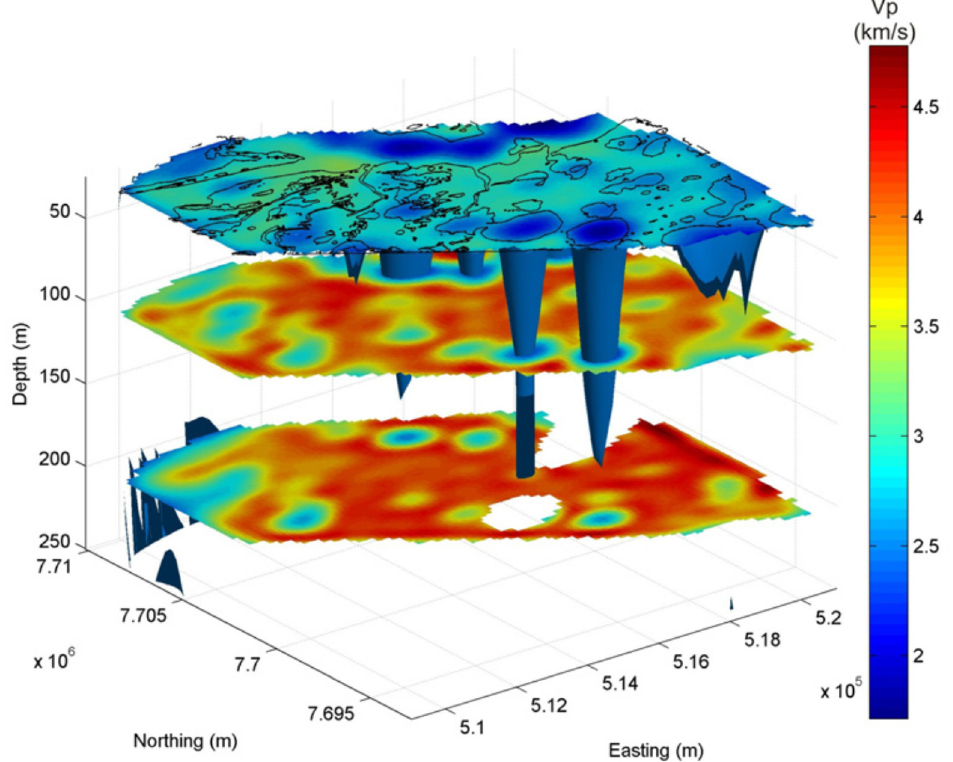
Figure 2. Tomographic inversion of direct seismic arrivals indicating inverted-cone shaped regions of lower velocities underneath lakes and other surface drainage, some extending to depths of ~300 m